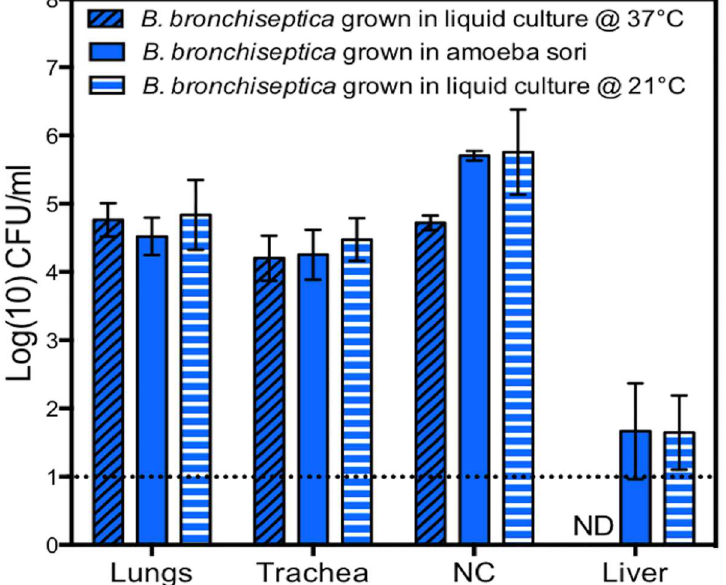
Fig 11. B . bronchiseptica recoveredfrom sori efficiently infects mice. Bacterial numbers recovered from respiratorytracts and livers of mice ( n = 4) on day 3 post inoculation with B . bronchiseptica recoveredfrom sori of D . discoideum (clear bars) or grown in culture at 37˚C (black hatchedbars) or 21˚C (white hatched bars). A grey dotted line indicatesthe limit of detection. NC signifies “nasalcavity.” ND signifies“not detected.” CFU, colony-forming unit. For further details, please see S1